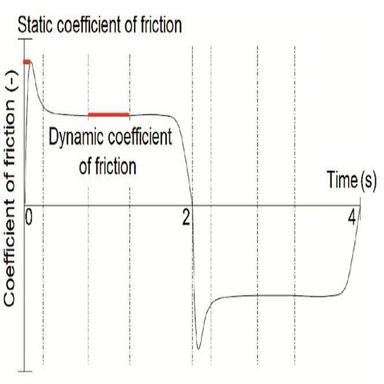
Friction curve during one test cycle.